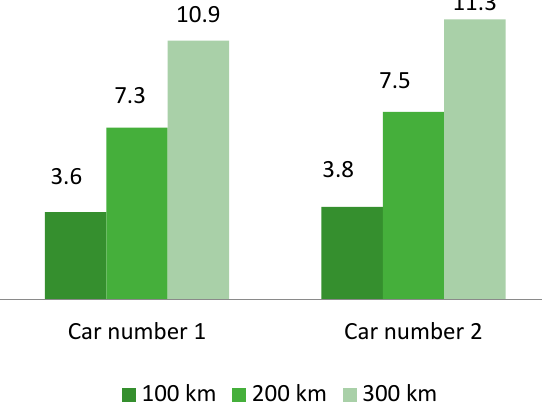
Figure 5. Fuel consumption of cars.